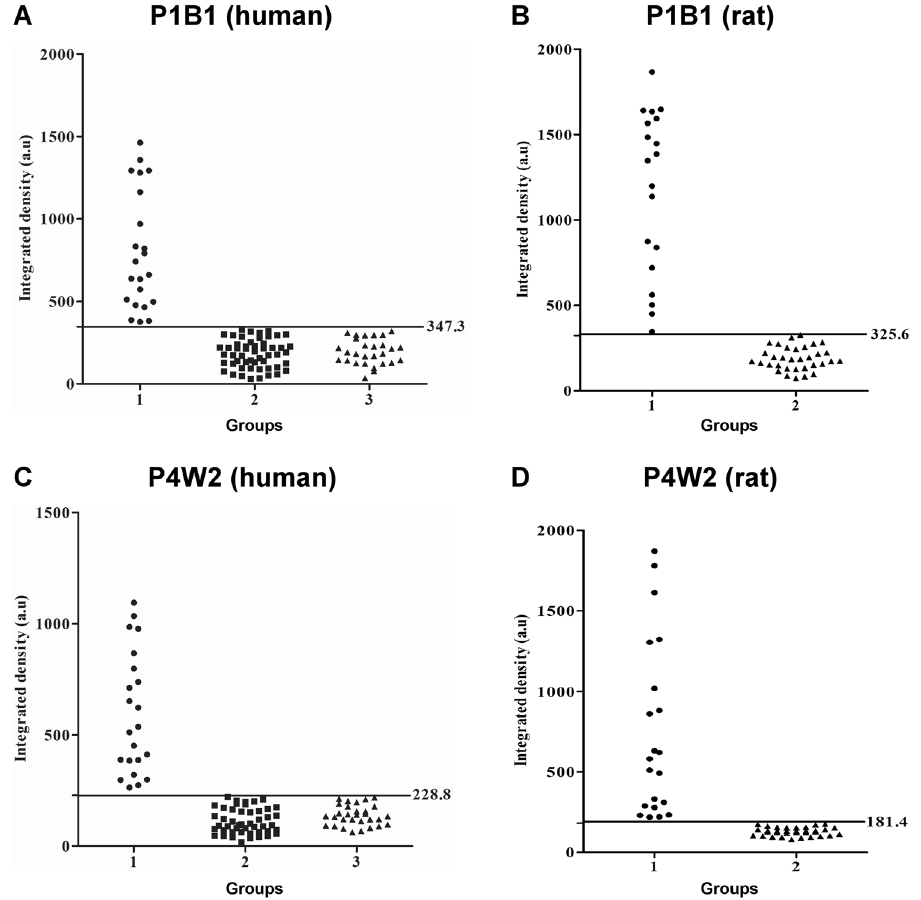
Figure 4. Evaluation of MAbs for antigen-capture in dot blot ELISA for diagnosis of leptospirosis. Study groups are indicated on the x axis and intensity of the dots on the y axis. Sensitivity and specificity of the MAb based dot blot ELISA for P1B1 ( A,C ) and P4W2 ( B,D ) are shown. Study groups for humans: Group 1 - Laboratory confirmed cases of leptospirosis; Group 2- Confirmed for other infectious diseases; Group 3 - seronegative healthy controls. Study groups for rats, Group 1- seropositive samples, and Group 2 - seronegative rats. The line represents the cut-off with the absolute values on the